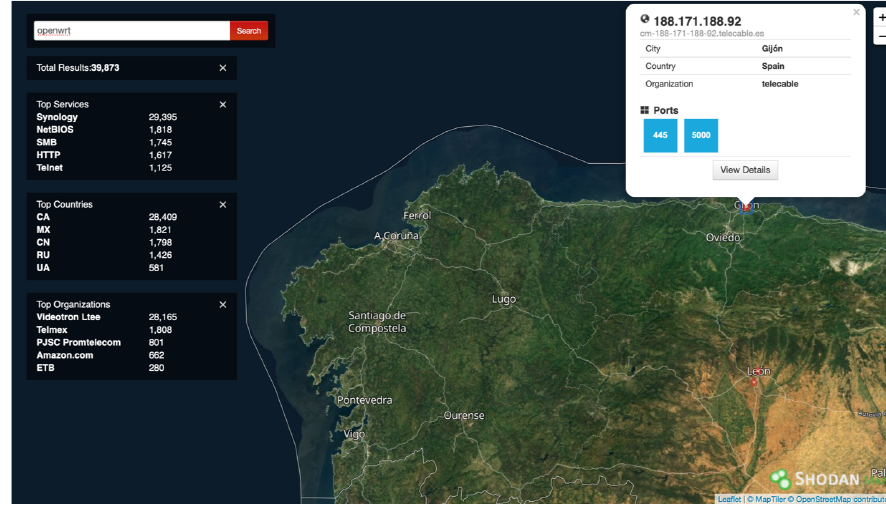
Figure 7. Shodan Maps interface.